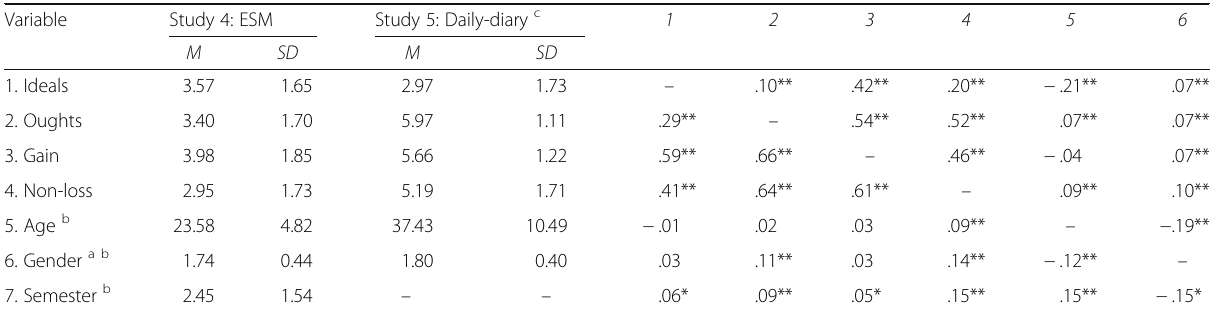
Table 5 Descriptive statistics and intercorrelations of momentary RF and demographic variables (studies 4 and 5) Variable Study 4: